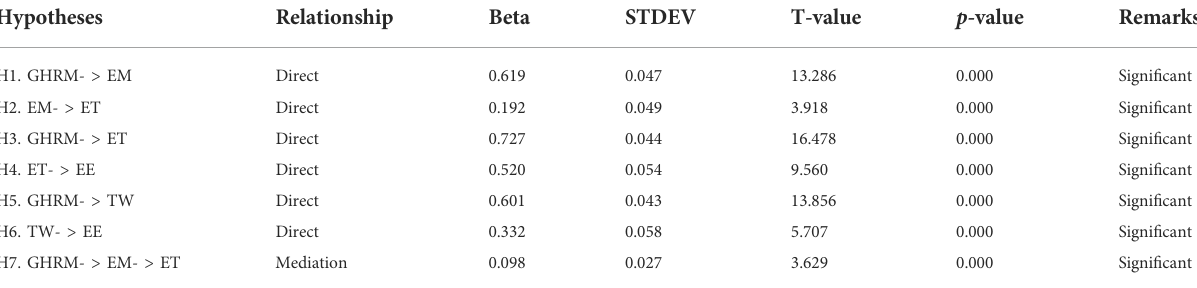
TABLE 3 Result of direct and indirect